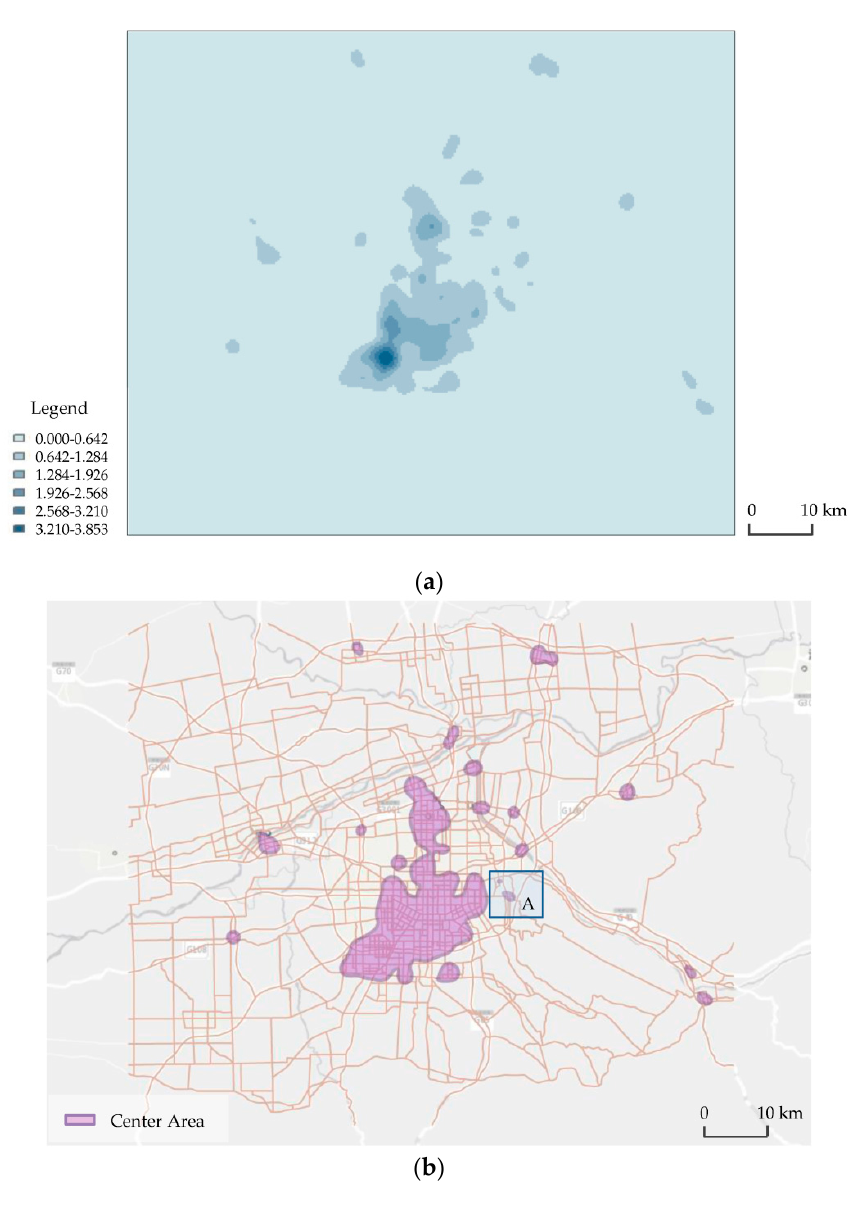
Figure 13. ( a ) Results of kernel density estimation of road nodes in Xi’an; ( b ) center areas by the contrast method in Xi’an.